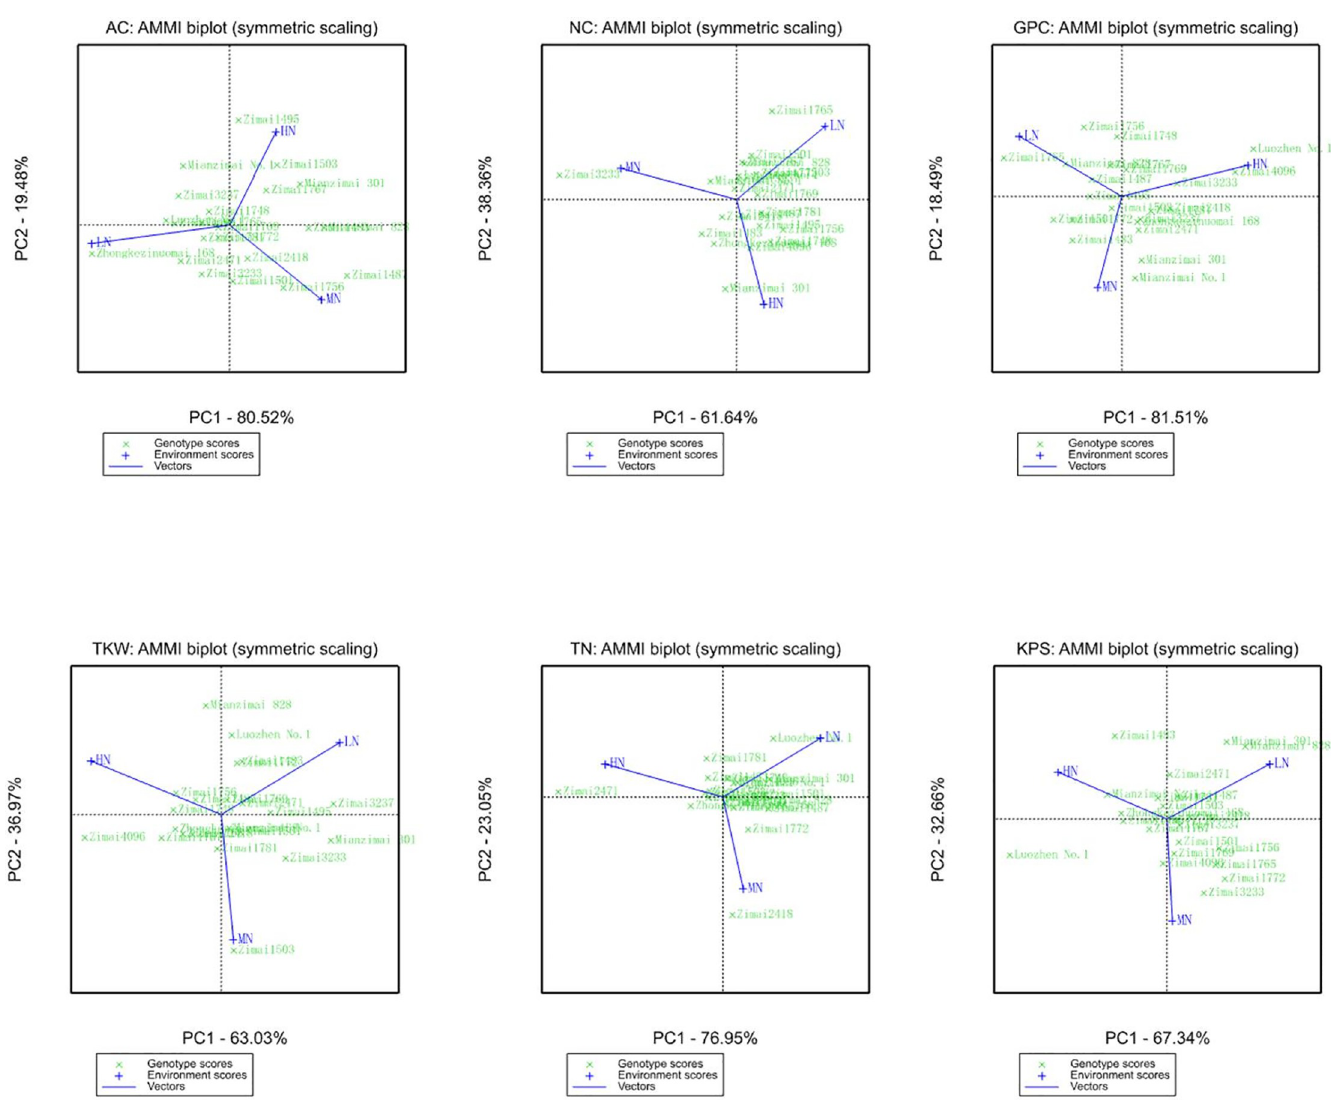
Fig 3. AMMI analysis of purple wheat lines for nutrient quality and yield composition